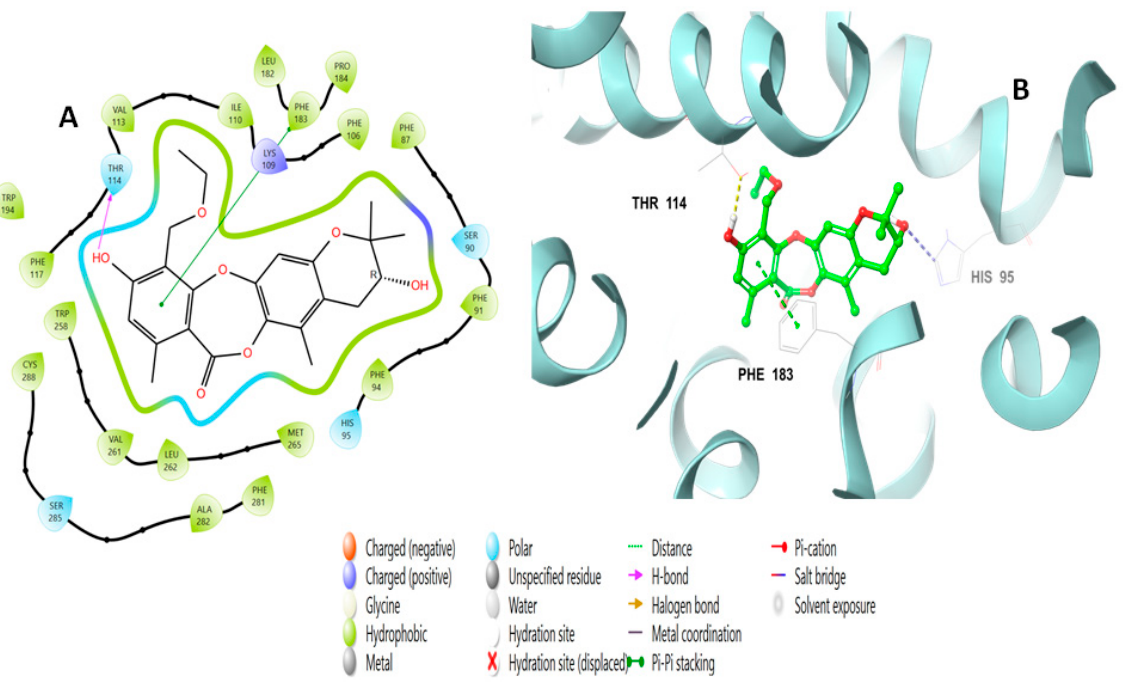
Figure 6. Putative binding mode of mollicellin Q ( 101 ) at the binding site of the CB2 receptor (PDB-ID: 6KPF). Mollicellin Q ( 101 ) is displayed as green sticks. H bonds are displayed as yellow dotted lines, and ionic bonds as blue dotted lines. ( A ) Two-dimensional view; ( B ) three-dimensional view of CB complexed with mollicellin Q ( 101 ).